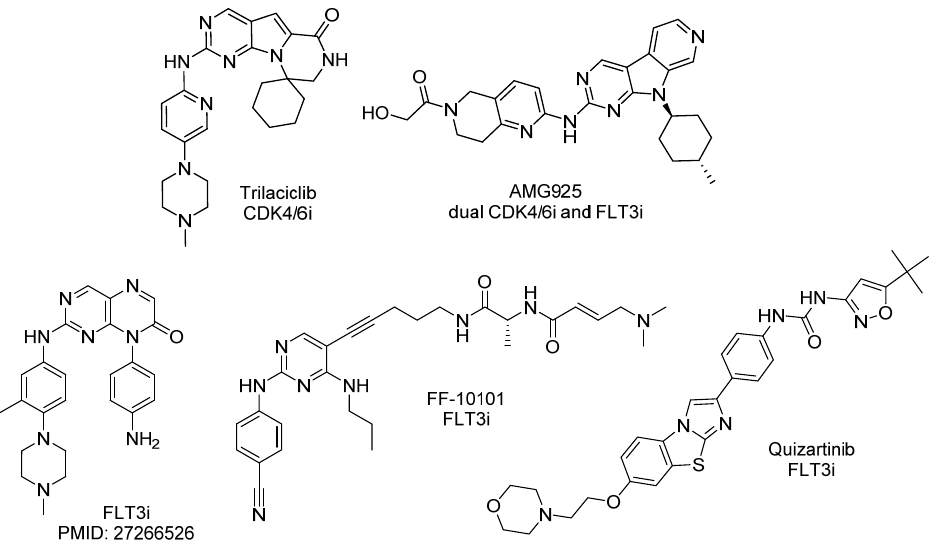
Figure 1. Example of inhibiting FLT3 kinase inhibitors.